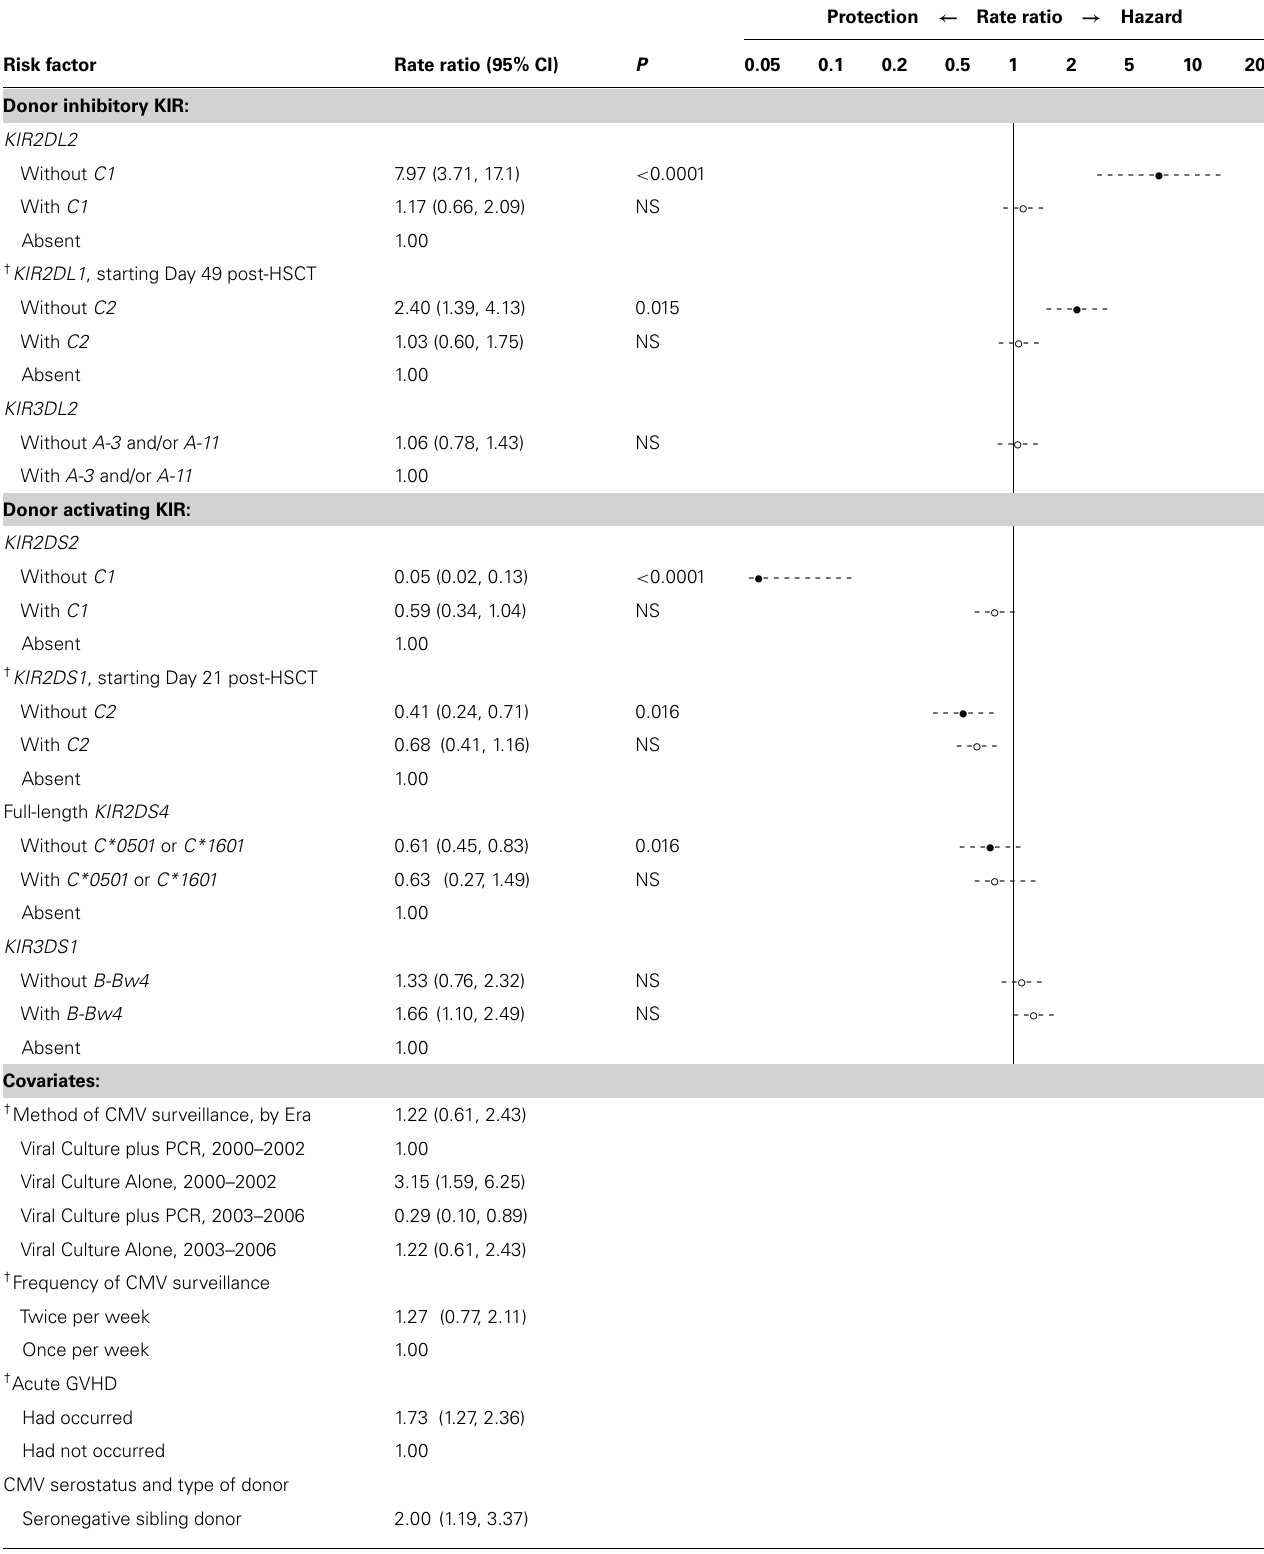
Table 3 | CMV reactivation-free survival after HLA-matched, allogeneic HSCT ( N =